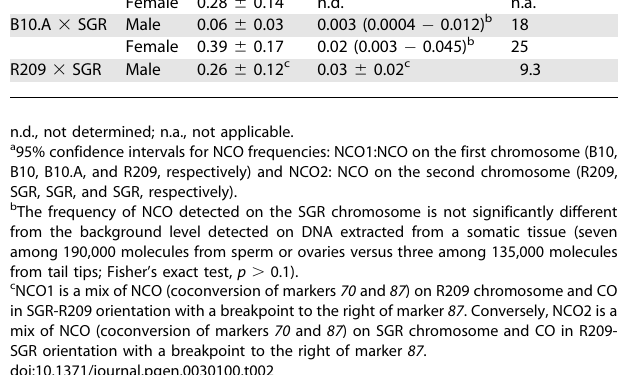
Figure 3. Distribution of Exchange Points at an Initiation Site (A) A model for meiotic recombination is shown. The region surrounding the initiating DSB, between the breakpoints (arrowheads), is converted. The molecule having suffered the initiating DSB is the recipient of genetic information [2,3]. The CO exchange breakpoints are shifted in opposite directions, depending on which is the initiating chromosome (left panel, Chromosome 1 and right panel, Chromosome 2). (B) The expected distribution of CO exchange breakpoints at an initiation site is shown: blue, Chromosome 1 to Chromosome 2 orientation; red, Chromosome 2 to Chromosome 1 orientation; black, sum of exchanges in both orientations. On the left panel initiation is mainly on Chromosome 1. On the right panel initiation on both chromosomes is with similar frequency.